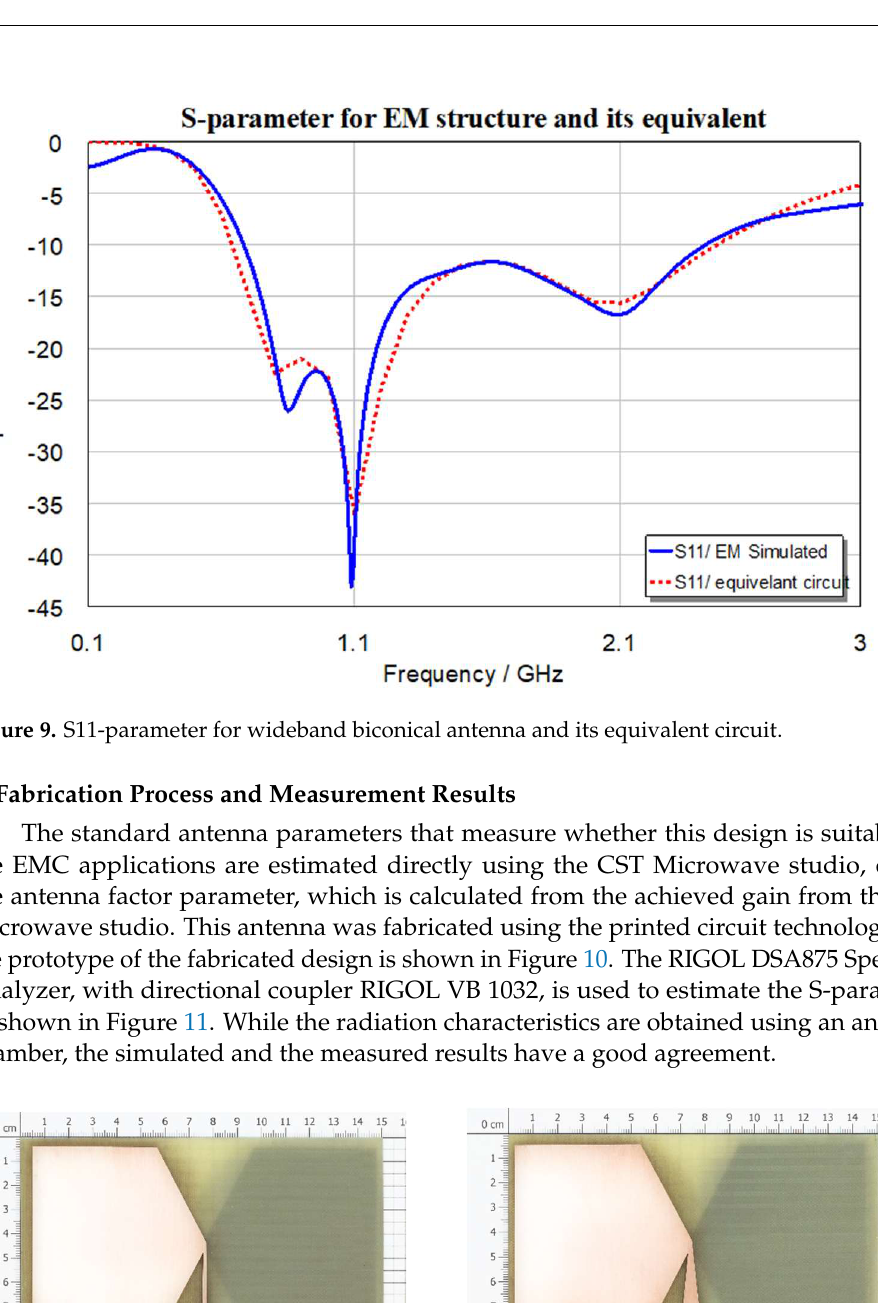
Figure 8. Equivalent circuit of the wideband biconical printed antenna.